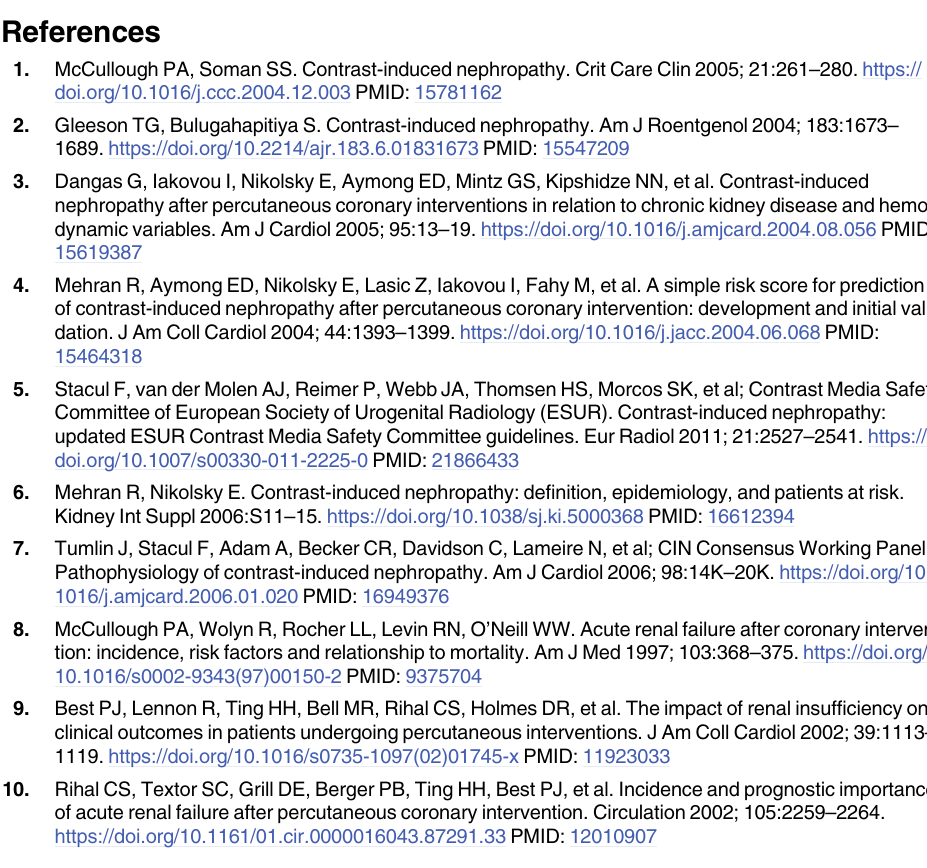
S1 Table. Baseline characteristics of patients with or without